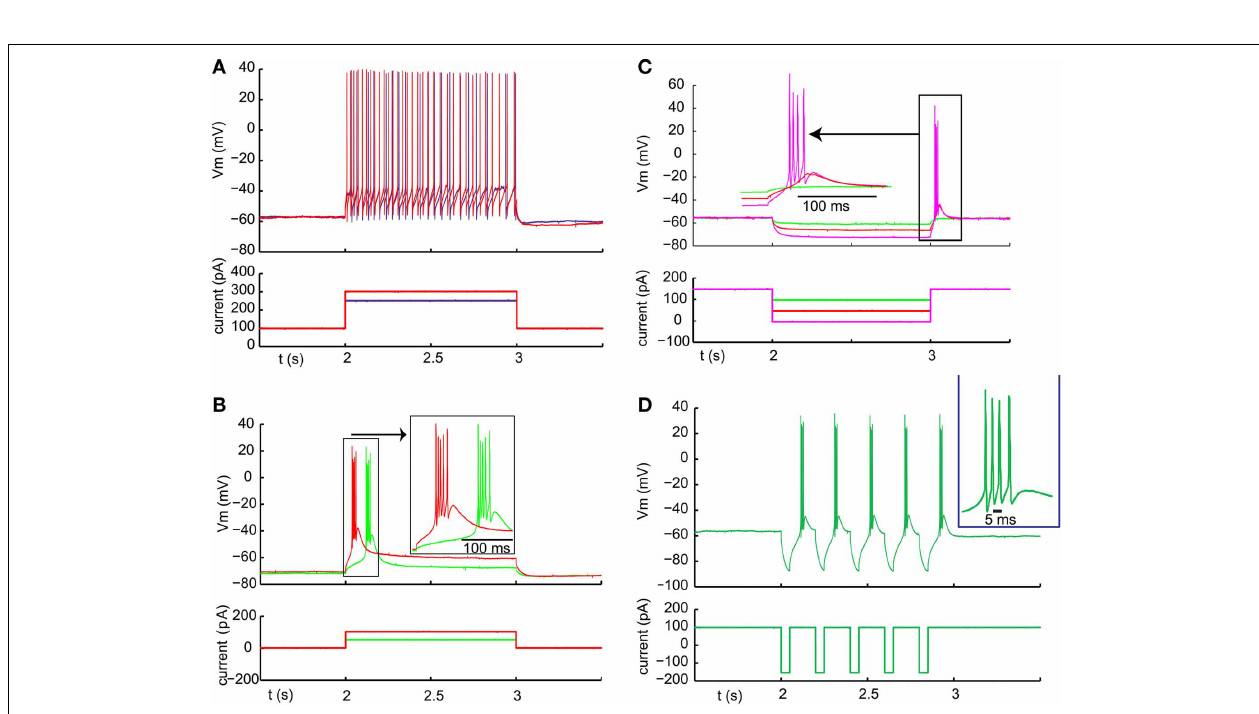
electrode. (B) Outward currents elicited with a light pulse of varying duration between 1 and 0.2ms in voltage clamp at − 50mV holding potential. Note that the response is graded with stimulus duration and shows multiple peaks at longer stimulus duration. Even with the shortest stimulus duration, however, failures were not observed, arguing against this ∼ 100pA response being carried by a single synapse. The response latency from light stimulus to IPSC onset was 3.2ms in this neuron.